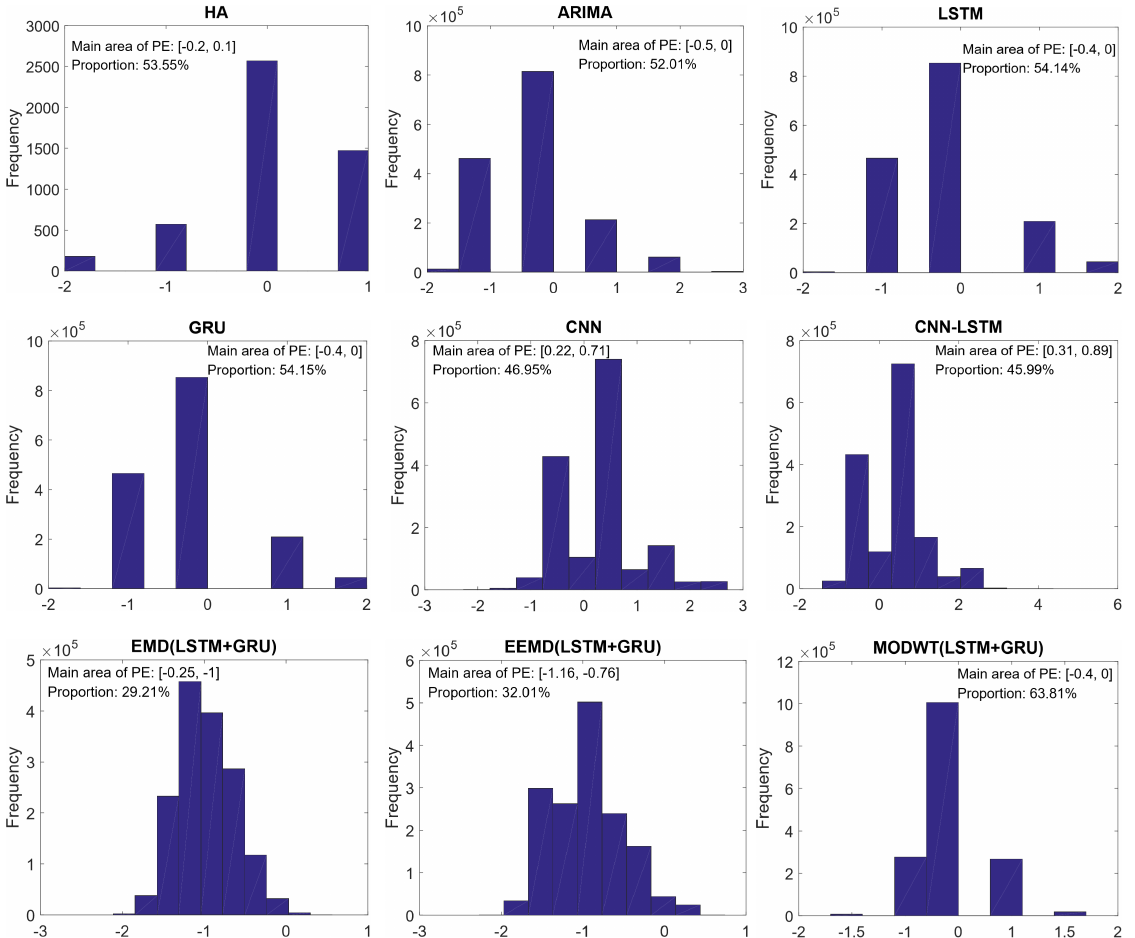
Figure 9. Histograms of the frequency of Prediction Error (PE) of different